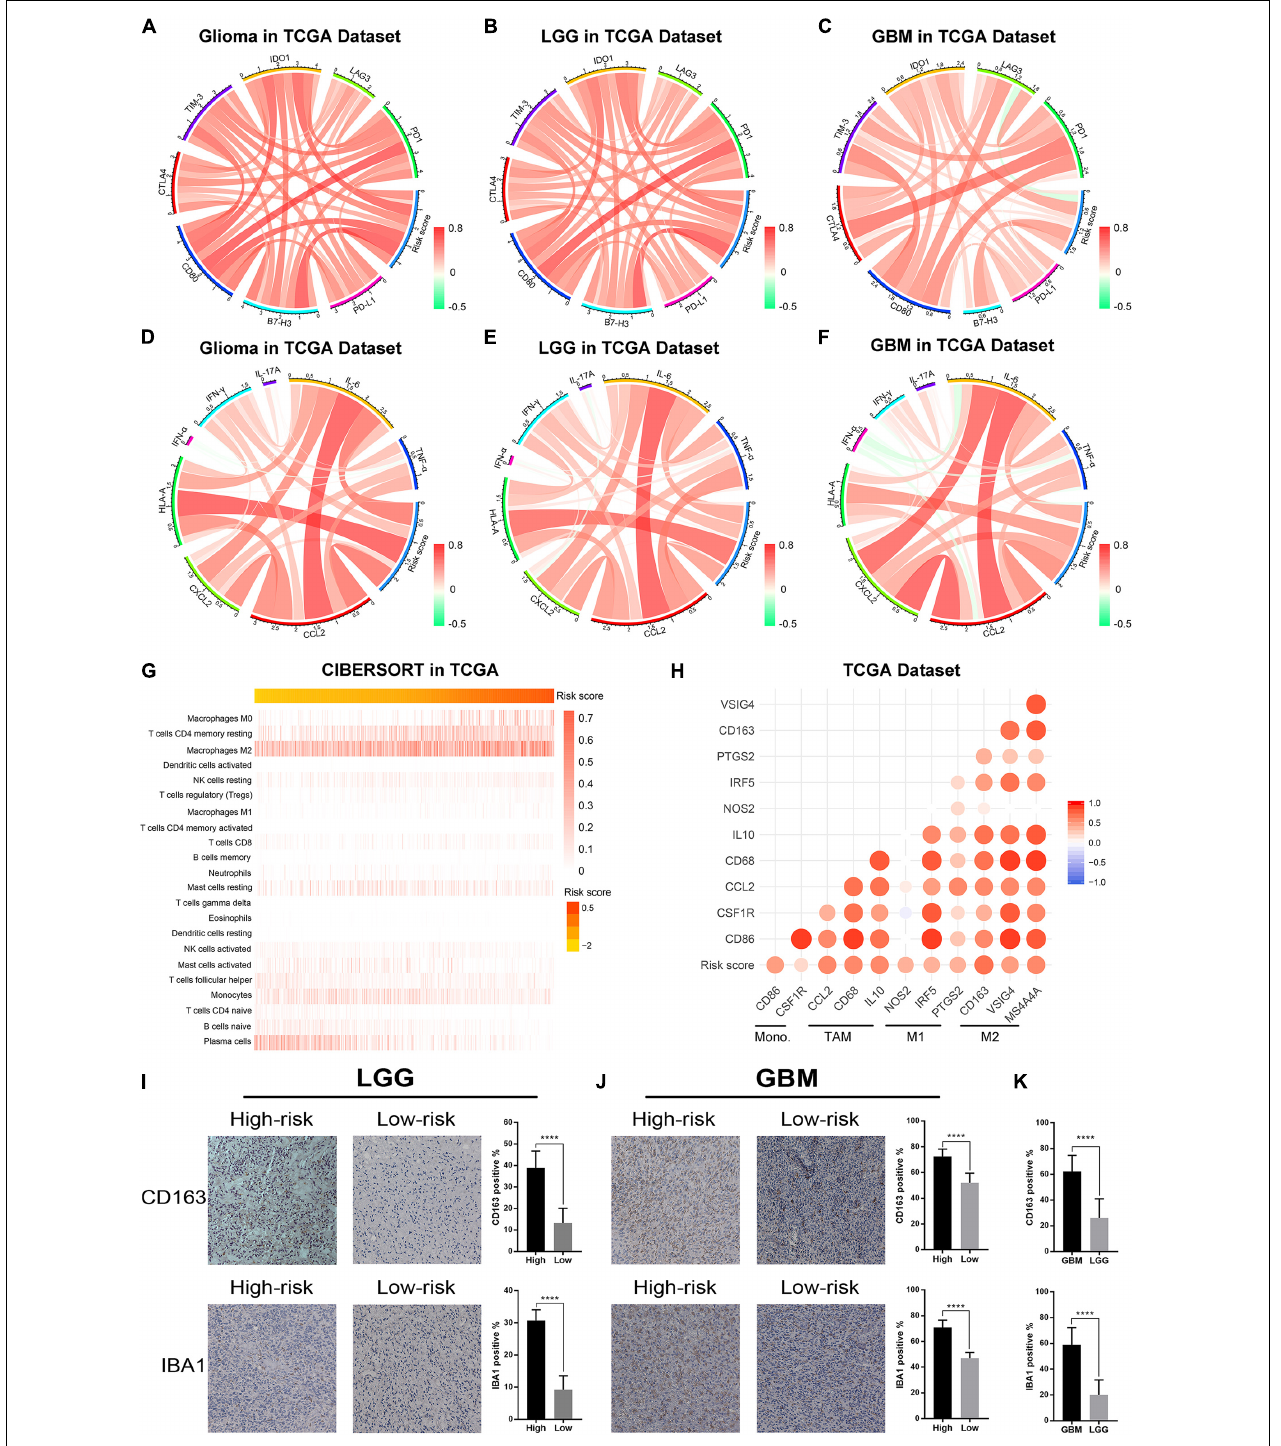
FIGURE 6 | The ER stress activation related immunologic events in glioma samples in TCGA dataset. (A–C) Correlation analysis between risk score and immune checkpoints in whole gliomas, low-grade gliomas and GBM, respectively. (D–F) Correlation analysis between risk score and inflammatory genes in whole gliomas, low-grade gliomas and GBM, respectively. (G) CIBERSORT was performed to evaluate the proportion of various types of immune cell infiltrated into glioma samples. (H) Correlation analysis between risk score and biomarkers of monocytes and macrophages. (I) IHC staining and positive rate statistics of CD163 and IBA1 in LGG samples from the CGGA dataset. (J) IHC staining and positive rate statistics of CD163 and IBA1 in GBM samples from the CGGA dataset. (K) Positive rate statistics of CD163 and IBA1 between LGG and GBM samples from the CGGA dataset. **** p < 0.0001.